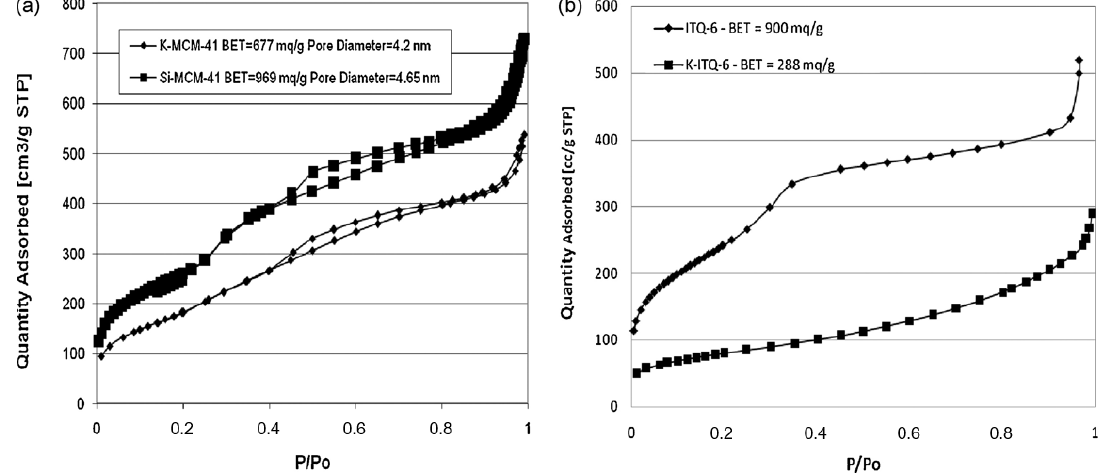
Figure 3. N 2 adsorption isotherms of catalyst ( a ) before and ( b ) after ionic exchange. Reprinted with permission from Ref. [49]. 2022, Elsevier.